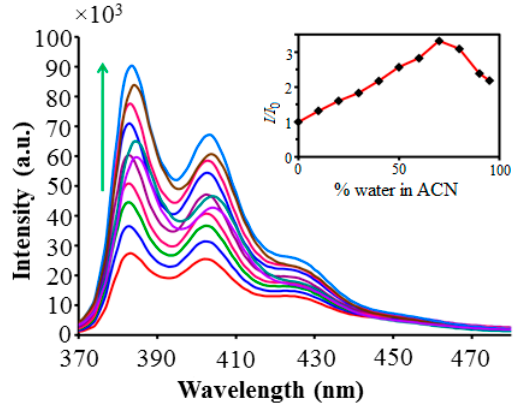
Figure 8. Aggregation-induced emission enhancement of 1 upon the incremental addition of water from 0% to 95% to ACN ( λ ex = 280 nm); Inset: change in intensity with respect to water fraction.